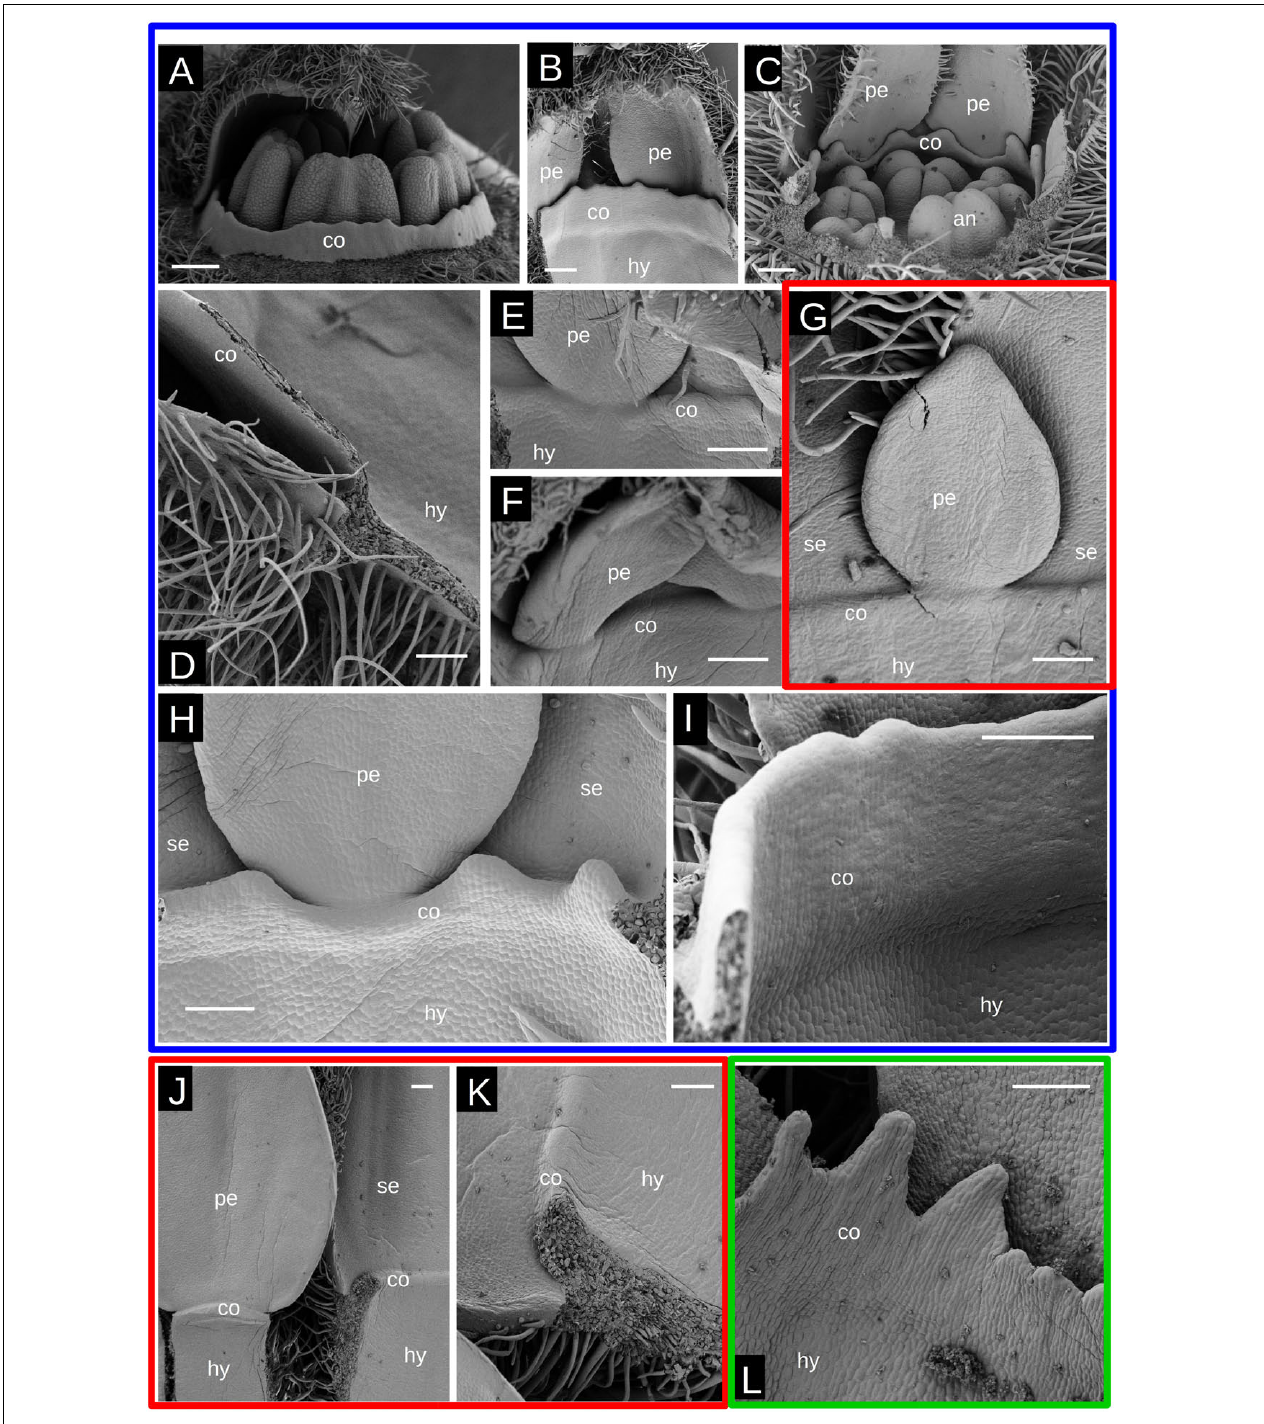
FIGURE 7 | Corona growth in Malesherbia. Red frame surrounds a Radiate species, green frame the minute species and blue frames surround Tubular species. (A) M. corallina showing a corona rim surrounding stamens. (B) Same species showing the perianth and corona rim from its ventral side. (C) M. tocopillana showing its more irregular corona surrounding androecium. (D) Detail of longitudinally sectioned well developed corona in M. auristipulata . (E) Corona being initiated in M. corallina . (F) Corona initiation in M. tenuifolia . (G) Corona initiation in M. densiflora . Note similar petal size in panels (E–G) (same magnification). (H) Corona growth in M. tocopillana . Note the irregular toothed shape. (I) Corona growth in M. auristipulata resembling a solid wall. (J) Delayed corona growth in M. lanceolata . (K) Same as in panel (J) showing detail of the slow growing corona. (L) Corona growth in M. humilis showing prominent teeth. co = corona, se = sepal, pe = petal, an = anther, hy = hypanthium. Same magnification panels (E–G) . Bars (A–C) = 200 µ m, (D–L) = 100 µ m.